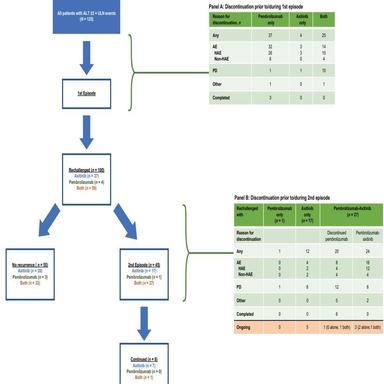
Outcome of all patients with ALT 3T ULN events, by episodes. AE = adverse event; ALT = alanine aminotransferase; HAE = hepatic AE; PD = progressive disease; ULN = upper limit of normal.